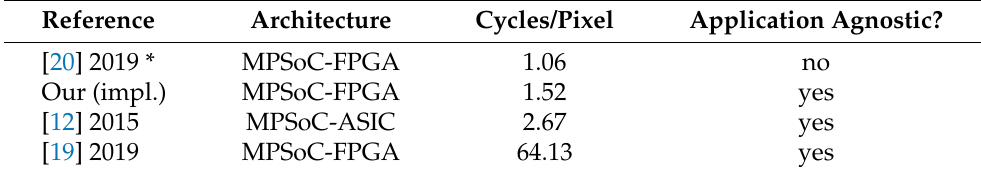
Table 4. Comparison of implementations of Sobel edge detector.